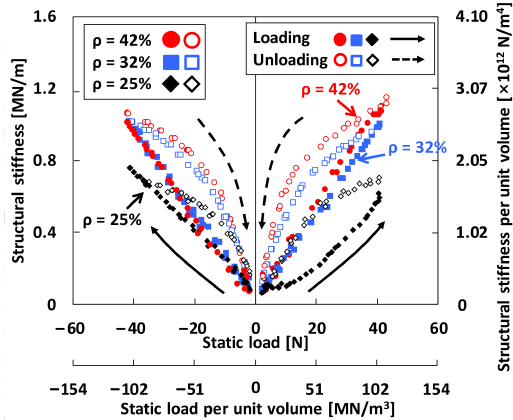
Figure 6. Full hysteresis loop measurements: Structural stiffness (left vertical axis) and structural stiffness unit volume (right vertical axis) versus applied static load (upper horizontal axis) and versus applied static load per unit volume of WMD (lower horizontal axis). The circle, square, and diamond symbols denote the structural stiffnesses of the WMDs with 42%, 32%, and 25% densities, respectively.